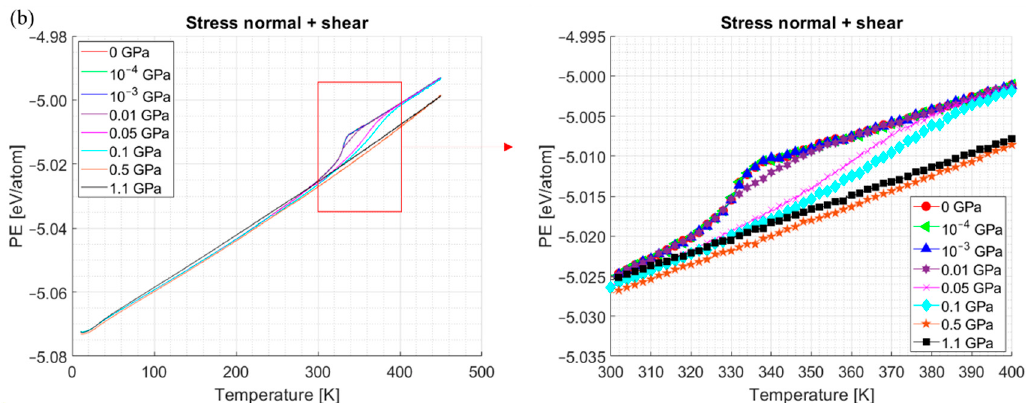
Figure 3. PE profiles during cooling and heating from simulation domain under both hydrostatic pressure and shear stress: ( a ) cooling, ( b ) heating.